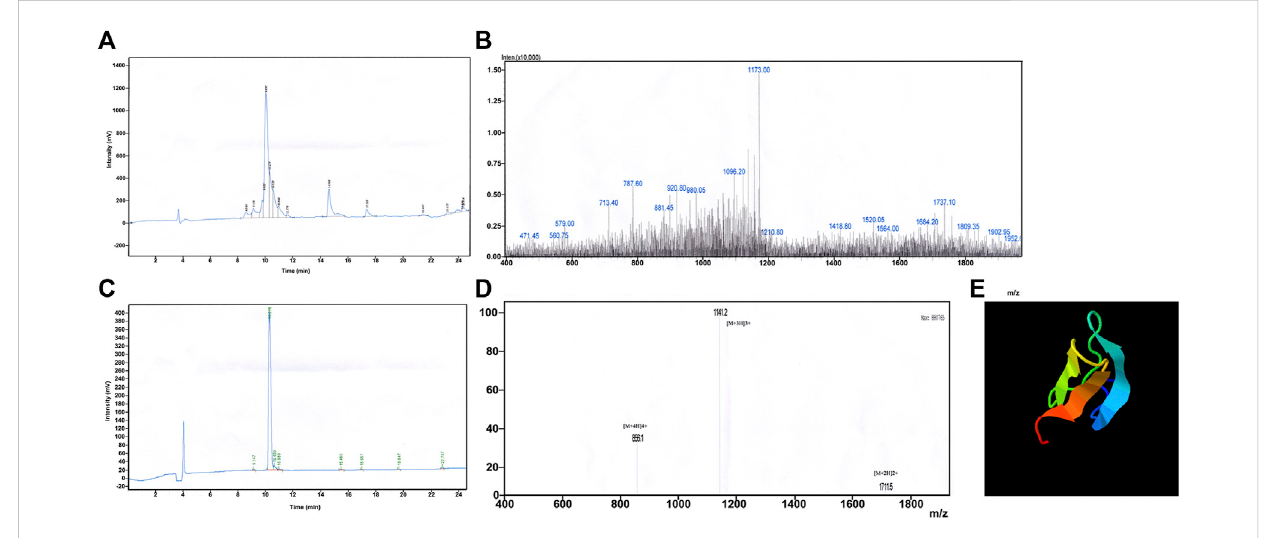
FIGURE 1 Synthesis and redox refolding of peptides. (A) Reversed-phase HPLC pro fi le after peptide synthesis; (B) Identi fi cation of synthetic peptides by MALDI-TOF/TOF mass spectrometry; (C) Reversed-phase HPLC pro fi le of the peptide after renaturation; (D) Identi fi cation of peptides after refolding by MALDI-TOF/TOF mass spectrometry; (E) 3D structure prediction by